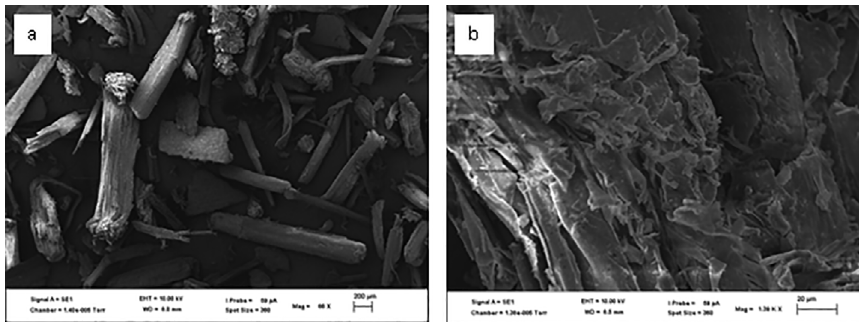
Figure 2. SEM micrographs of raw sugarcane bagasse